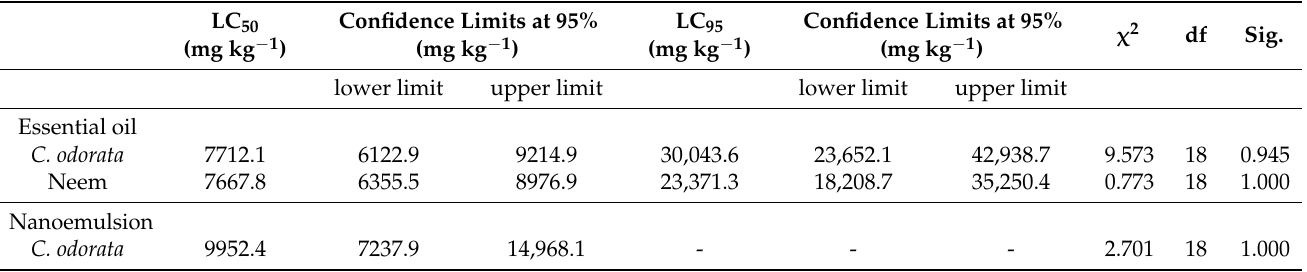
Figure 7. Mortality (mean (%) ± SE) of first-instar larvae of Spodoptera frugiperda measured by the effect of the concentration (mg kg − 1 ) of the Cedrela odorata essential oil, alone or in a nanoemulsified formulation. Mortality was recorded on day seven. Positive control: neem essential oil; negative control: Tween 80–Span 80 surfactant mixture. Two-way ANOVA. Dots with the same letter (a–h) do not significantly differ (Bonferroni test for an α = 0.05). Table 5. LC 50 and LC 95 of the Cedrela odorata essential oil applied in a ketone solution and a nanoemulsion against first-instar larvae of Spodoptera frugiperda .